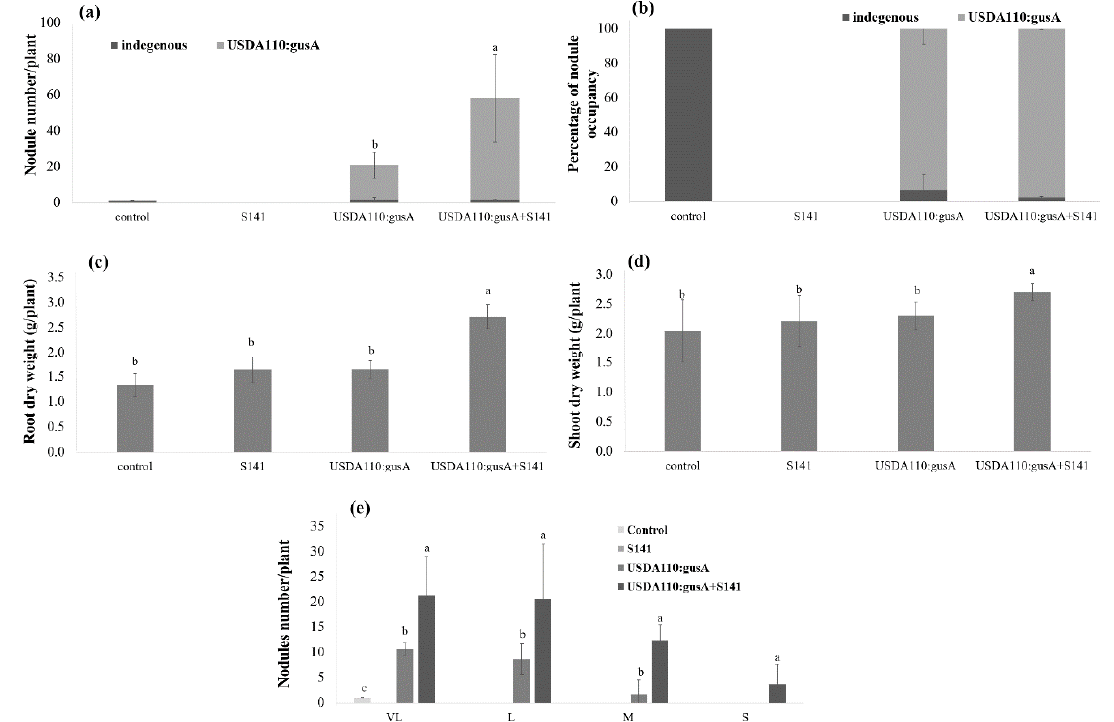
Figure 4. Plant growth parameters of soybean cultivar Chiang Mai 60 by co-inoculation with S141 and GUS-tagged USDA110 at 45 DAI: ( a ) nodule numbers per plant; ( b ) percentage of nodule occupancy; ( c ) root dry weight; ( d ) shoot dry weight; and ( e ) nodule size separation. Significance at p ≤ 0.05 is indicated by mean standard error bars ( n = 5 ).